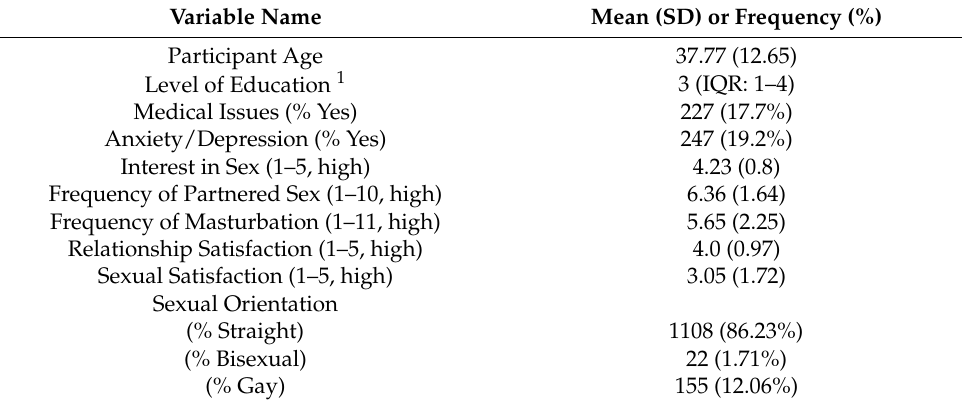
Table 1. Demographic characteristics of the study sample ( n = 1285).